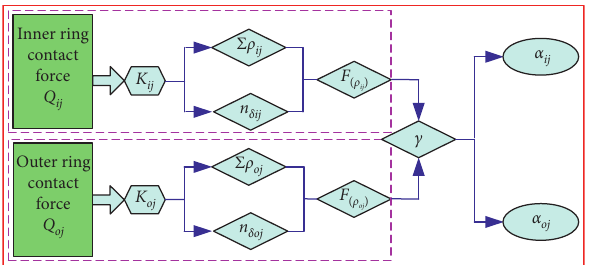
Figure 7: Analysis of variable transfer relationship of contact forces Q Q ij and oj .